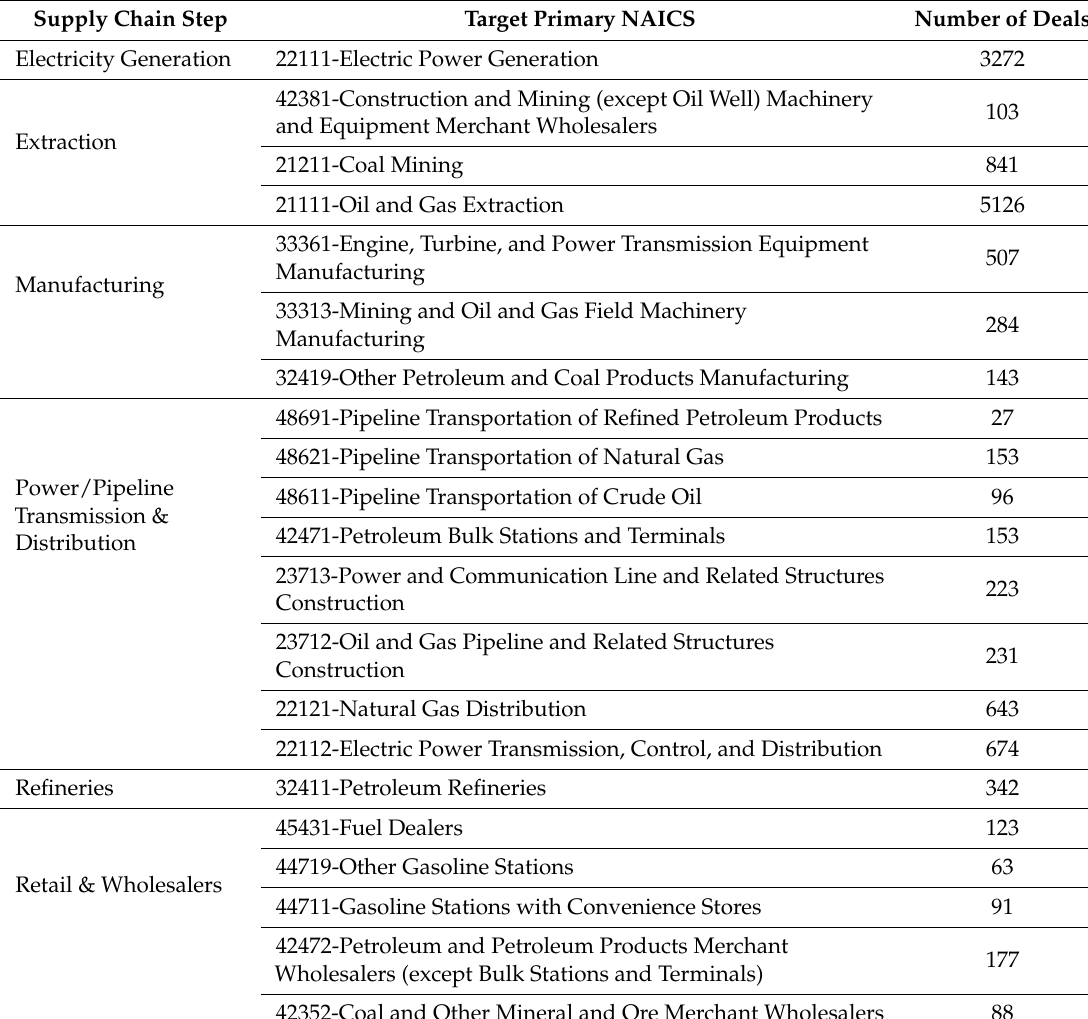
Table A1. Definitions for M&A Database,